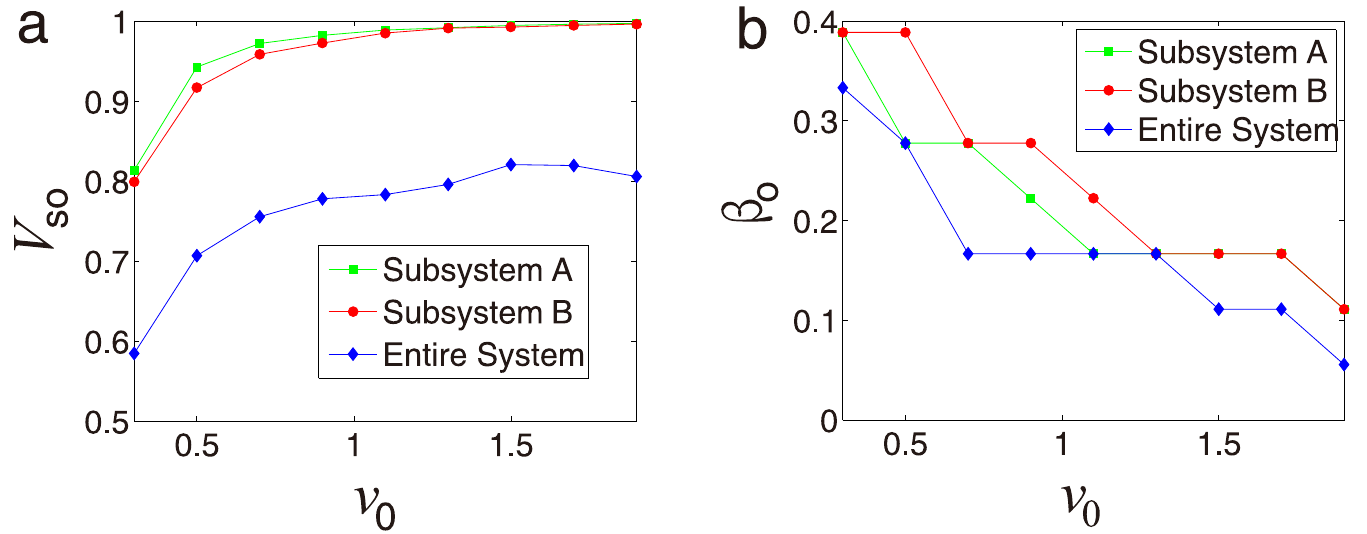
Fig 6. Absolute velocity effect for network of SPA systems coupled by predator-prey relationship. (a) Optimal synchronization V so as a function of the absolute velocity v o for each subsystem and the entire system. (b) Optimal coupling strength β o as a function of the absolute velocity v 0 for each subsystem and the entire system. The simulation results are saved in S5